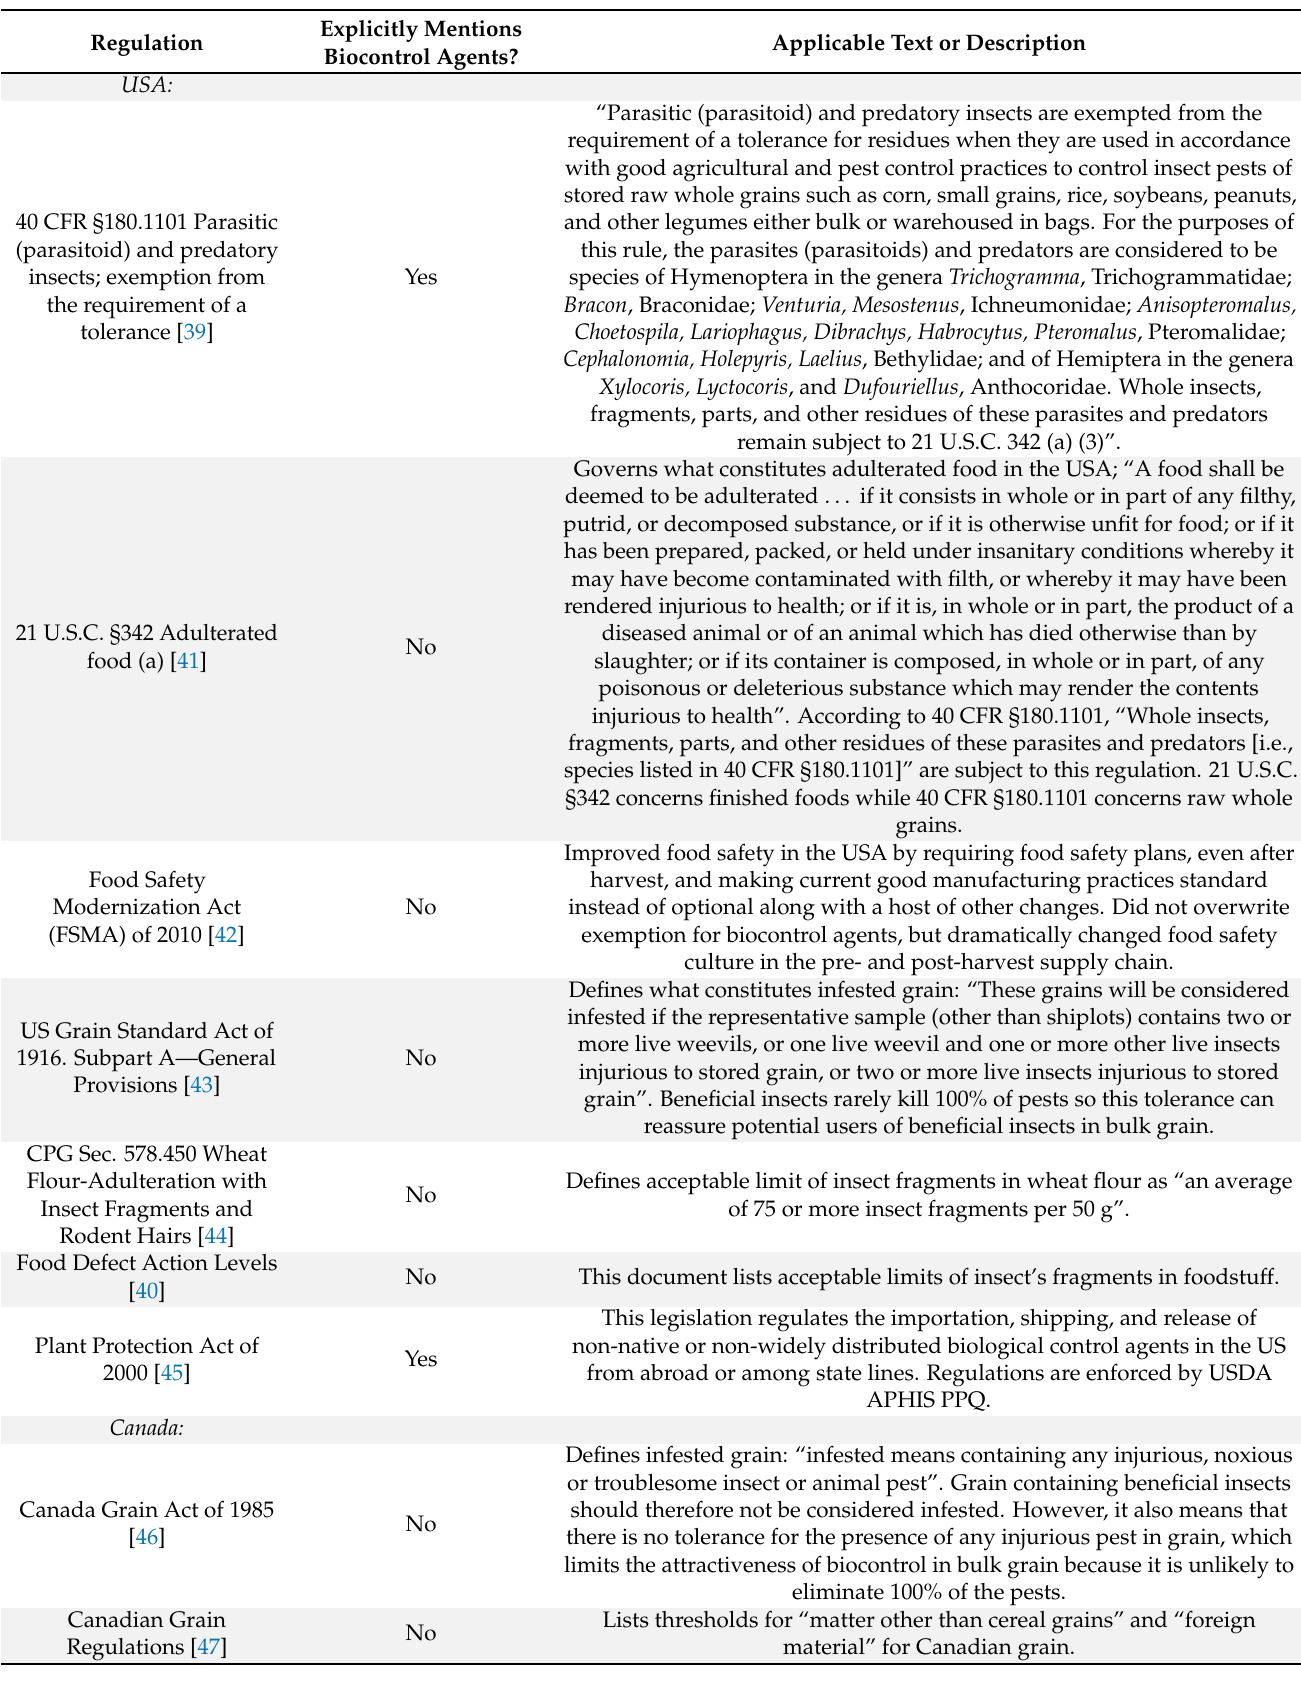
Table 1. Regulations regarding biocontrol agents and adulteration of stored products with insects in the USA and